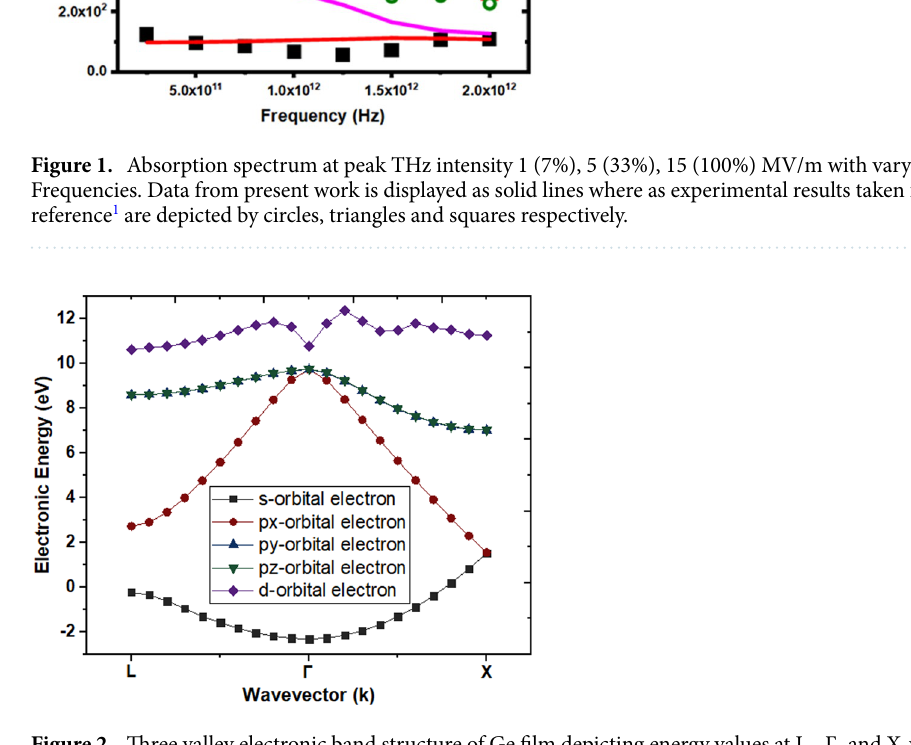
Figure 2. Three valley electronic band structure of Ge film depicting energy values at L-, Γ- and